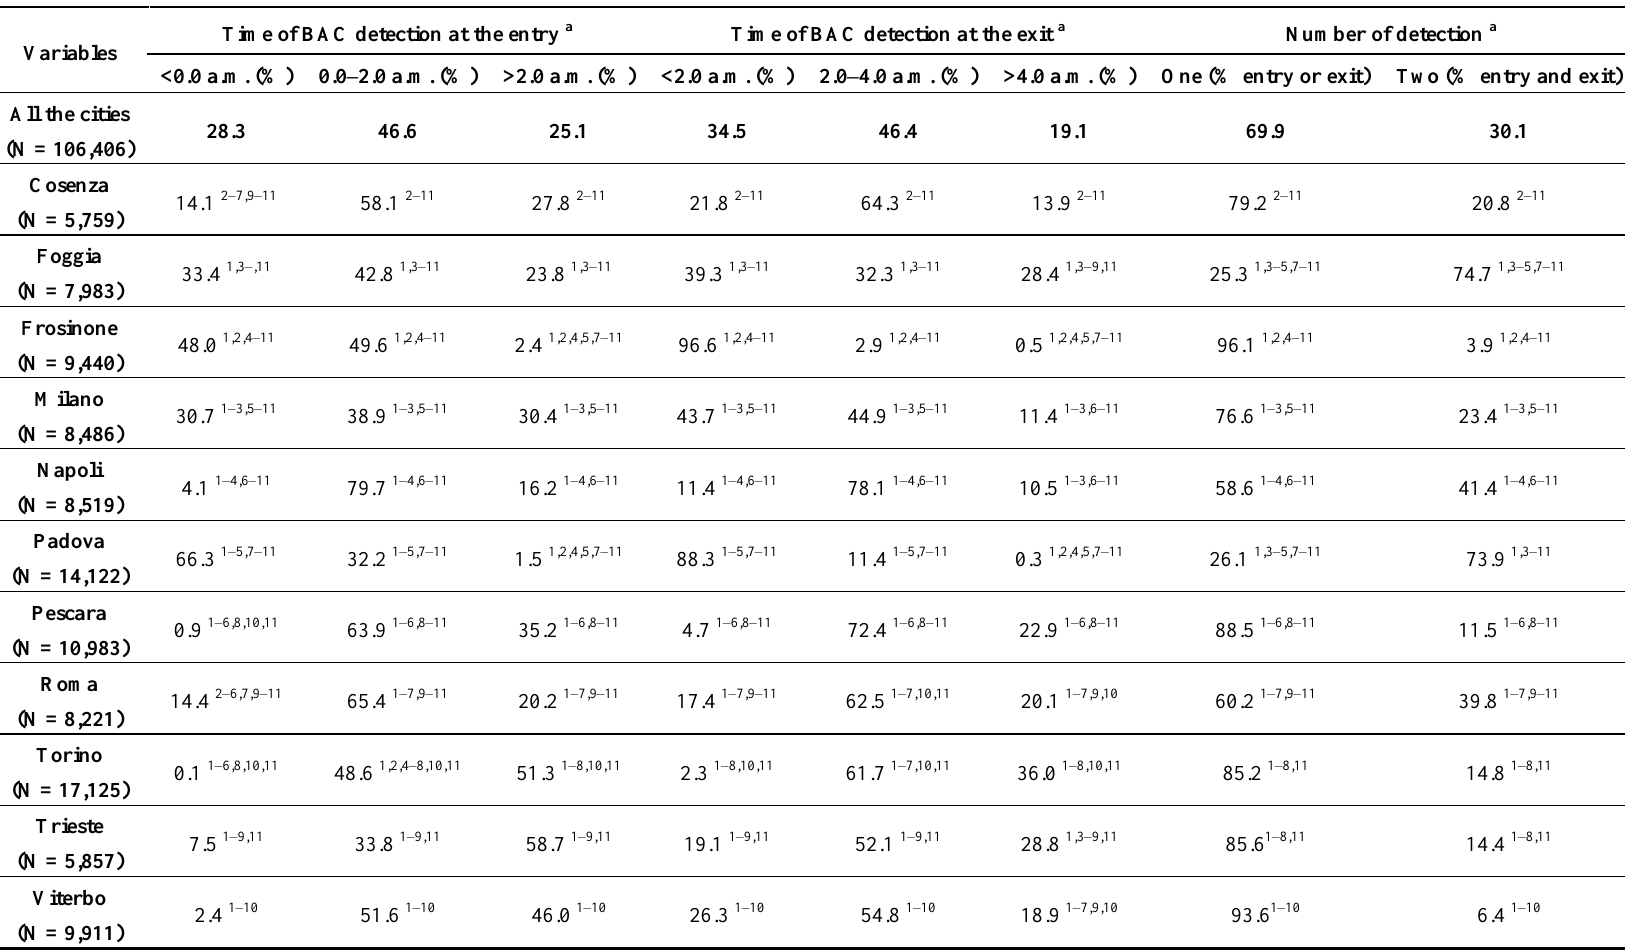
Table 2. Blood Alcohol Concentration (BAC) in all the participants, according to the city where they were